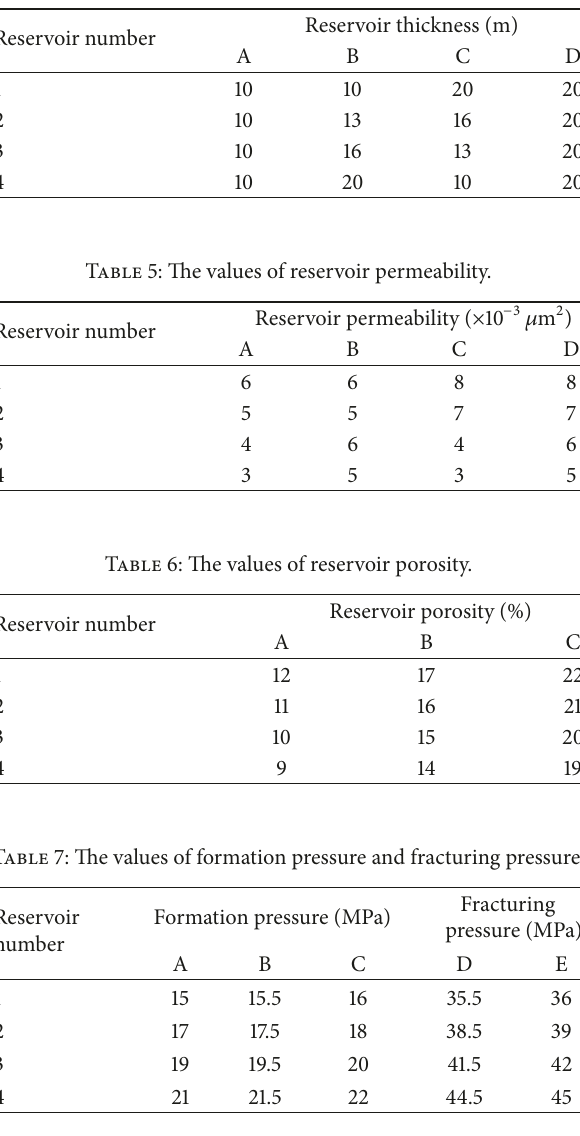
Table 4: The values of reservoir thickness.